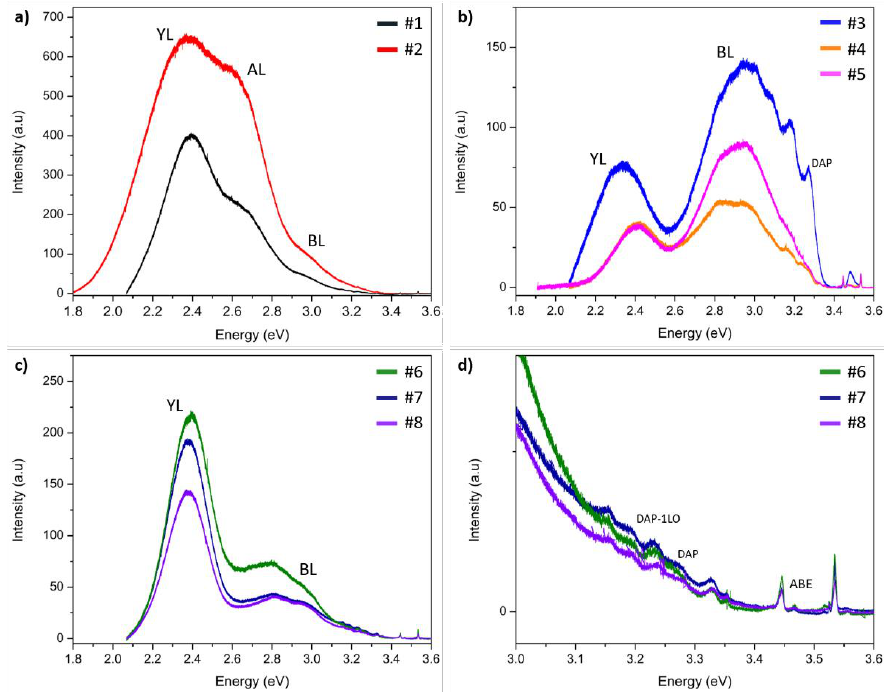
Figure 3. LTPL spectra for HVPE samples: ( a ) GaN:C; ( b ) GaN:Mn; ( c ) GaN:Mn,C; and ( d ) GaN:Mn,C in the range of 3.0 eV – 3.6 eV.